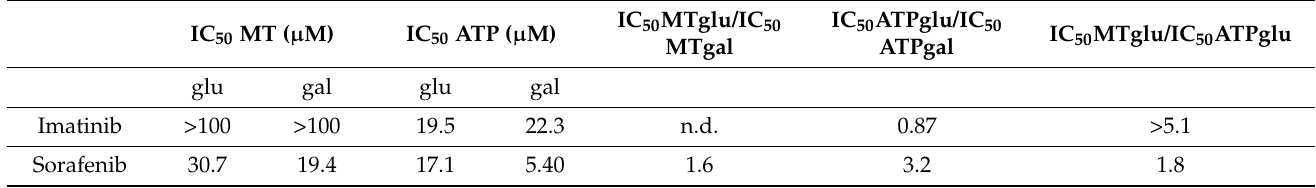
Table 1. Quantification of membrane toxicity and ATP depletion by imatinib and sorafenib in H9c2